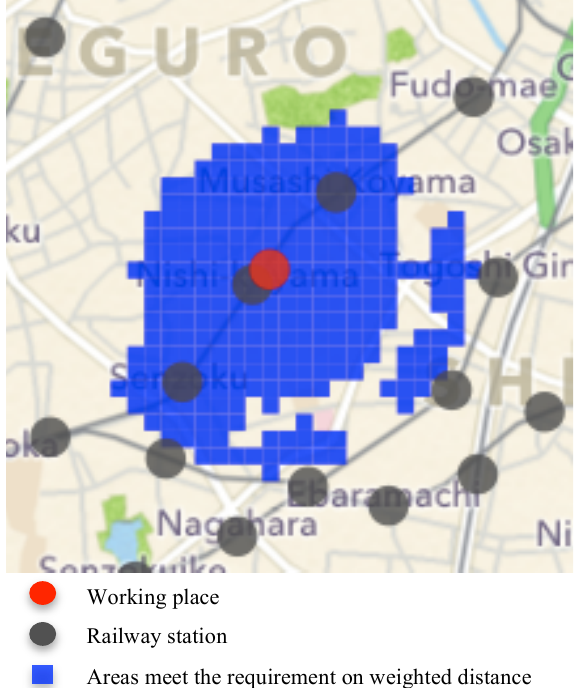
Figure 5. Areas that meet the requirements on weighted distance While we overlay the above two areas, we obtained the final result, the areas meet both requirements both on attributes and distances to important places. As shown in Figure 6, the blue areas meet the requirements on both attributes and weighted distances, and these areas are recommended to the user for renting apartments there; the green areas meet only the requirement on weighted distance; and the blue areas only meet the requirements on attributes. (The blank areas meet none of the requirements, or do not have apartments for